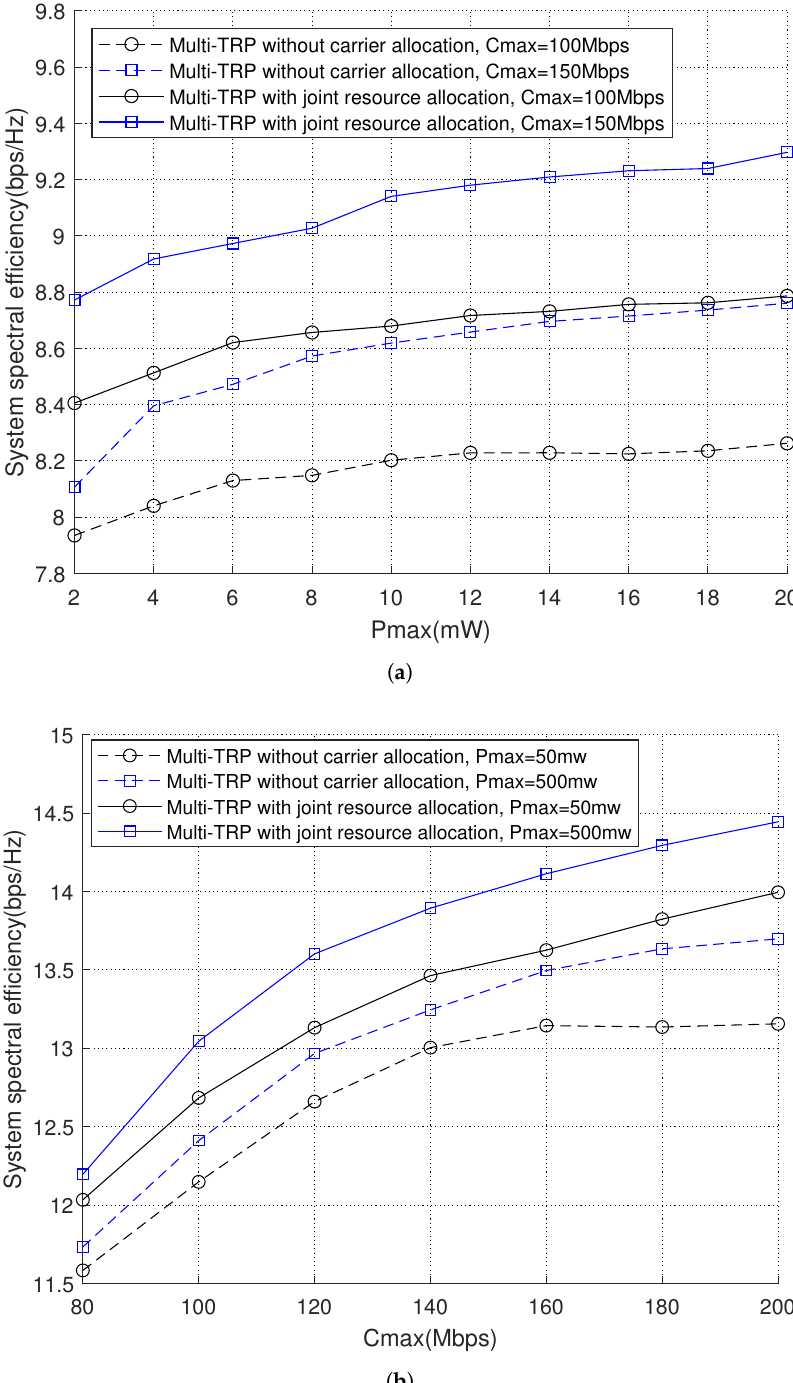
Figure 3. System SE comparison of the multi-TRP systems with and without carrier allocation. ( a ) System SE versus P max for different C max limitations. ( b ) System SE versus C max for different P max